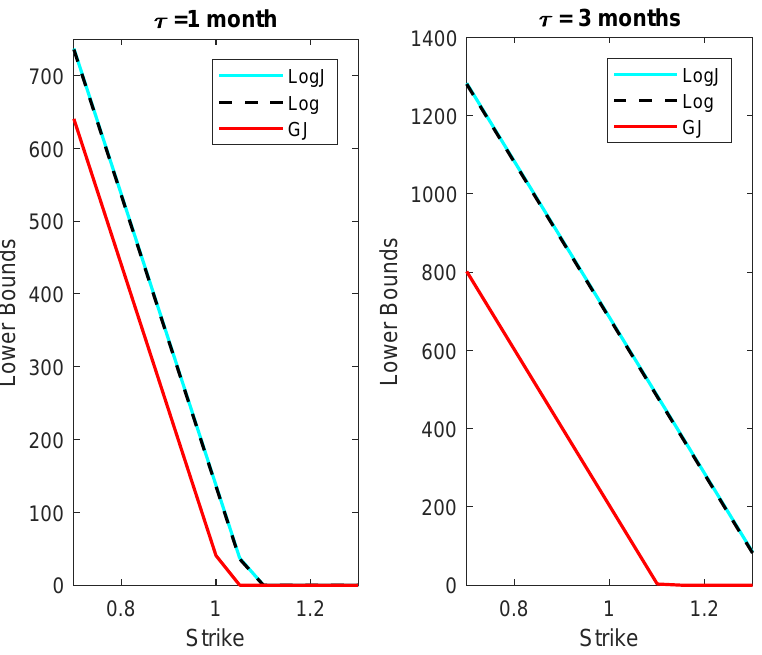
Figure 2. Lower bounds of freight options for S = 2000 and maturities of 1 and 3 months with the LogJ, Log, and GJ